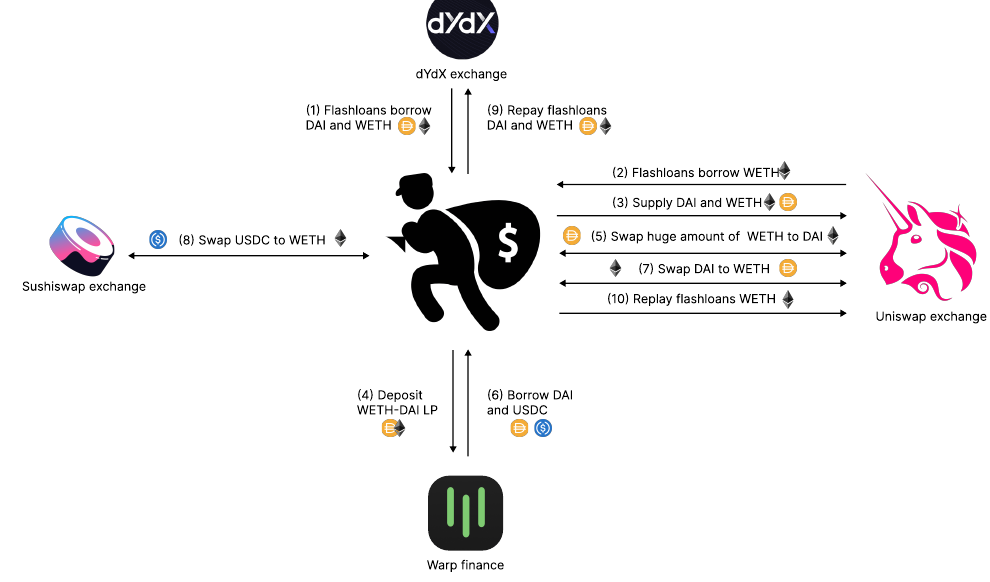
Figure 2. Warp finance attack